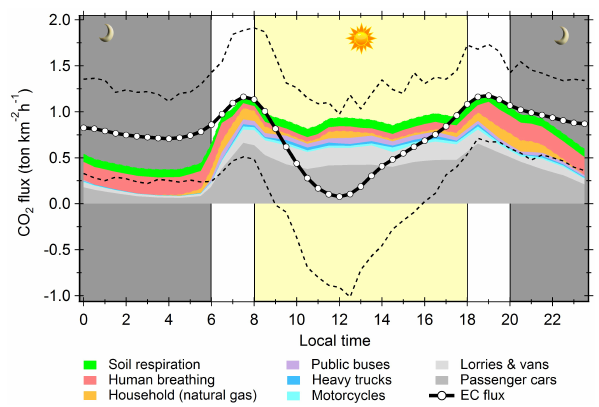
Fig. 2. Total CO 2 flux measured directly by EC and the sum of emissions from 8 source types within a 500m circle centered on the EC site estimated by bottom-up approaches. The difference be- tween the two methods is related to the influence of aboveground vegetation on the CO 2 exchange and is positive during nighttime because of dark respiration and negative during the day because of uptake through photosynthesis. Data are weekday averages. Dashed lines are ± 1 standard deviation from the EC flux average and give an indication of the day-to-day variability at every hour of the